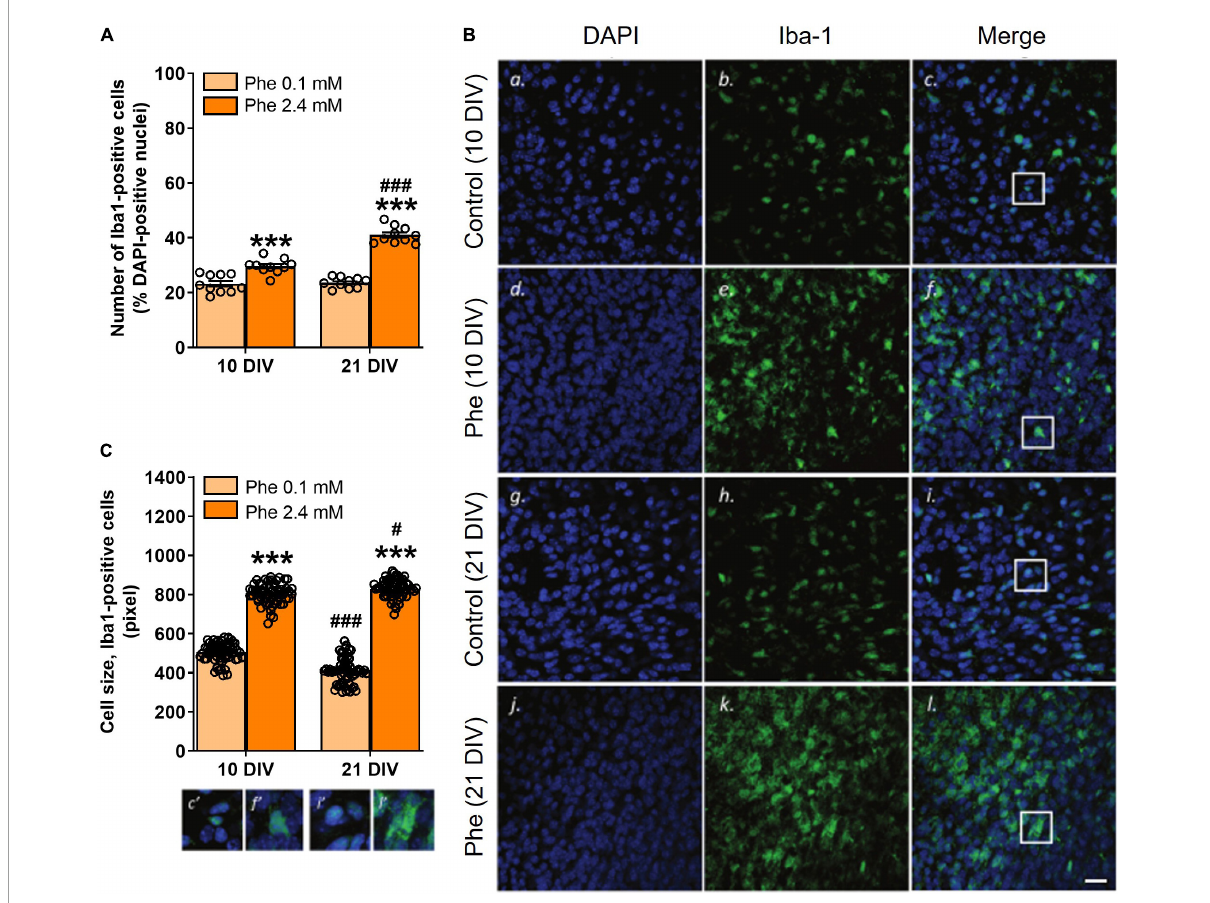
FIGURE4 Reactive microglia were seen as early as 10 DIV following continuous treatment with high phenylalanine. Cerebellar slices were incubated for 10 or 21 days in vitro (DIV) in a control medium or a medium containing phenylalanine (Phe) at 2.4 mM. The graphs show the results of the immunohistochemistry quantification. (A) Number of Iba1-positive cells as % of DAPI-positive nuclei from 20 fields of view per slice and 10 slices for each treatment group ( N = 10); representative images are shown in panels ( B c,f,i,l); (C) Size analysis at 10 and 21 DIV of 60 microglial cells sampled across 10 slices in each treatment group; corresponding images are shown in panels ( B c,f,i,l). Data are plotted as Mean ± SEM of N = 10 slices/group. The insets (c’, f’, i’, l’) show details of the colocalization of the two stainings and of the morphological differences between treatment groups and time points. Note the different morphologies (amoeboid vs. elongated) and sizes of the cells as a function of their activation state. Scale bar = 20 µ m. Statistical symbols indicate significance at *** P < 0.001 of Phe-treated slices vs. control slices and at # P < 0.05 and ### P < 0.001 of 21 DIV vs. 10